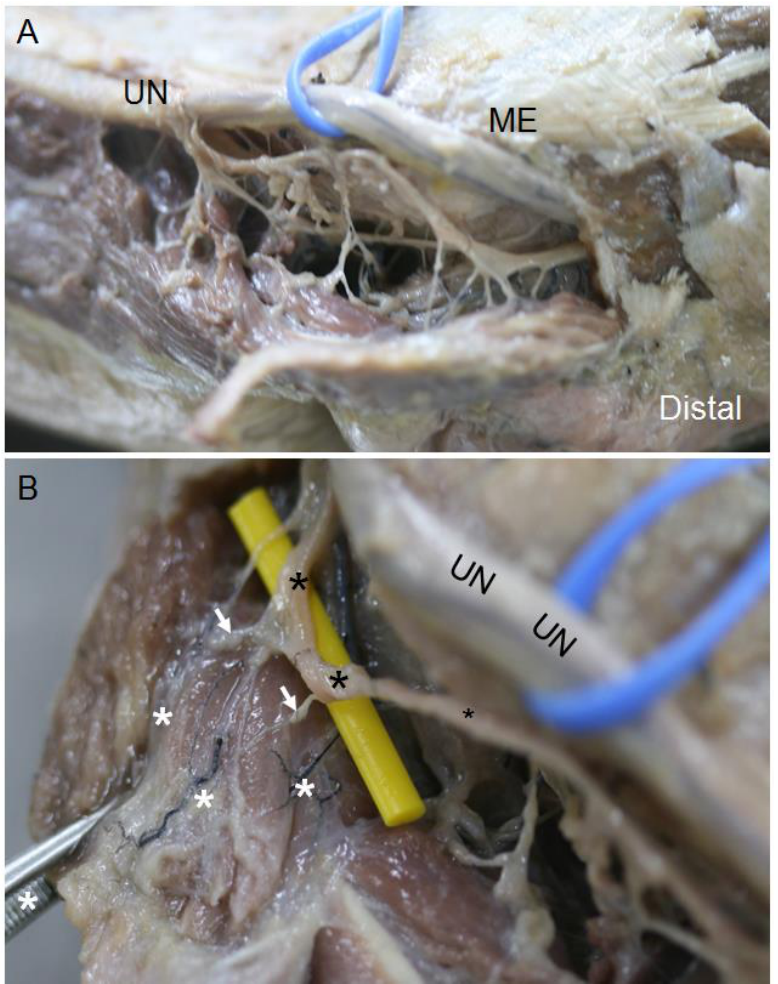
Figure 6 Figure 6. ( A ) Anatomical view of the ulnar nerve giving branches to the aberrant muscle at the level of the medial epicondyle (ME). ( B ) Collateral arteries (white asterisks), which originated in the posterior branch of the inferior ulnar collateral artery. At the very rear of the osteofibrous tunnel, the posterior ulnar recurrent artery accompanies the ulnar nerve (UN) at its path through the elbow. The white arrows indicate the nerve branches responsible for innervating this muscular variant, which originates in a UN branch (black